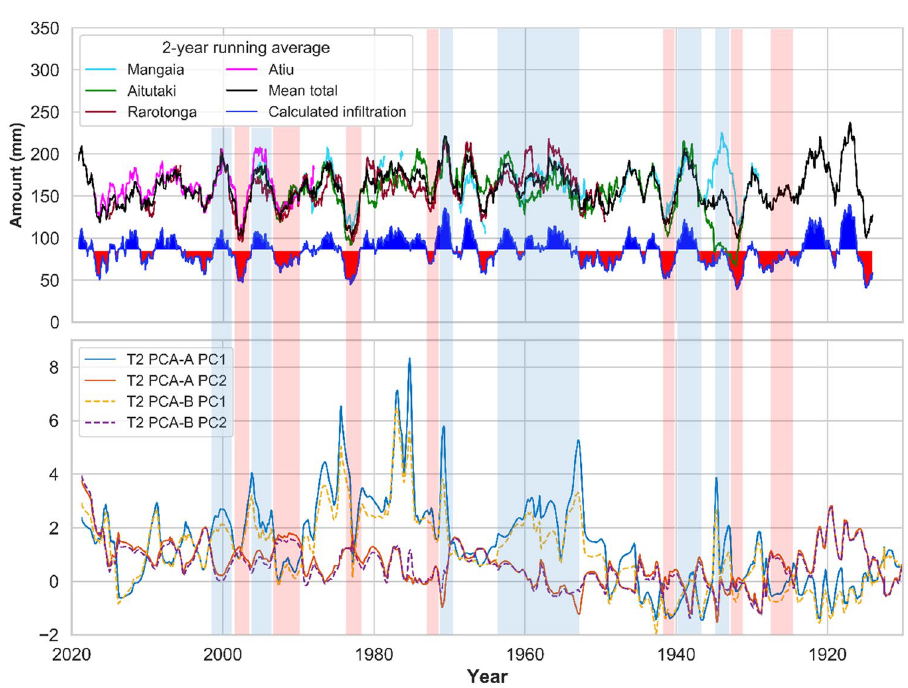
Figure 6. Comparison of principal components of trace elements with local infiltration record (1914–2019). Local infiltration was calculated by subtracting the potential evapotranspiration (PET) from the rainfall amounts at each island. The infiltration values of Mangaia, Aitutaki and Rarotonga were averaged and then tied with Atiu’s record. The blue (red) shadings of the calculated infiltration indicate positive (negative) anomalies from mean values of the period 1914–2019. The shaded light blue and light red vertical bands highlight the relatively wet and dry periods, respectively that are reflected in the principal components. PC1 of PCA-A correlates positively with infiltration values, whereas PC2 correlates